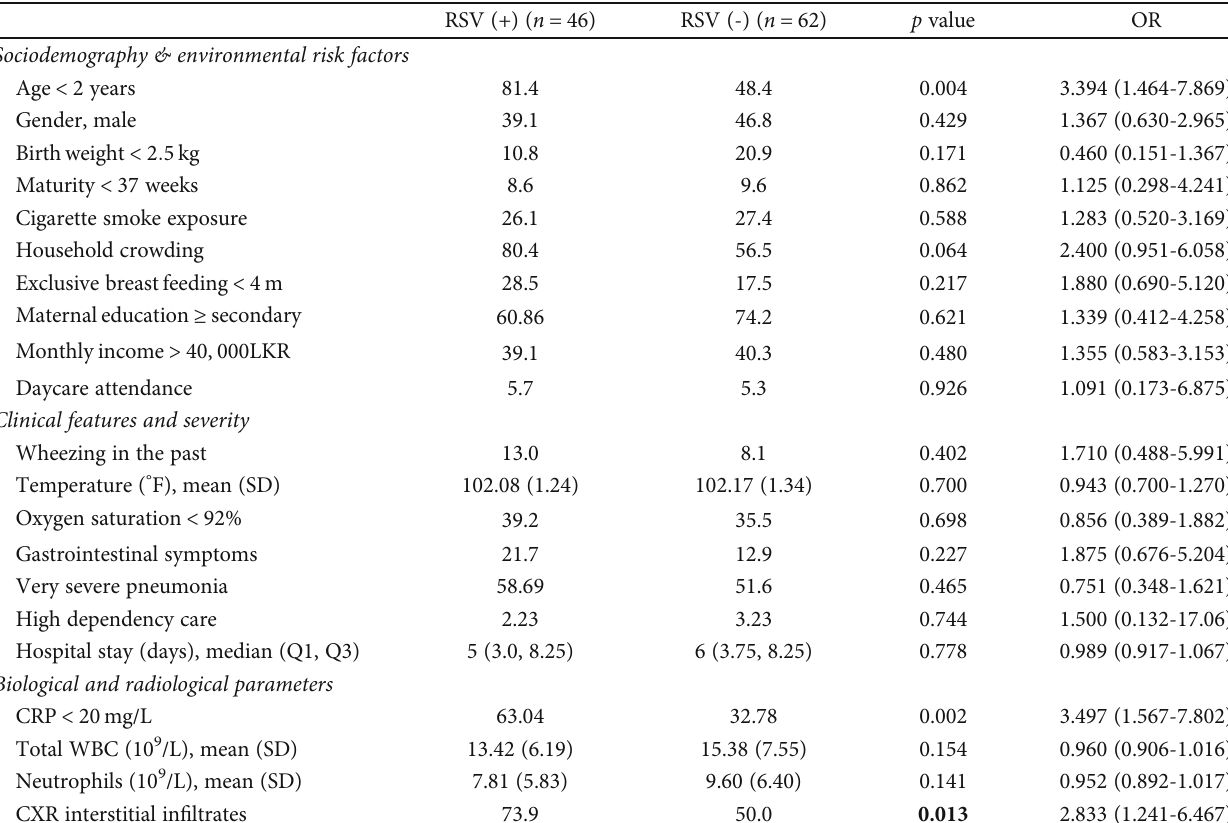
Table 1: Comparison of children with RSV (+) and RSV (-) pneumonia.